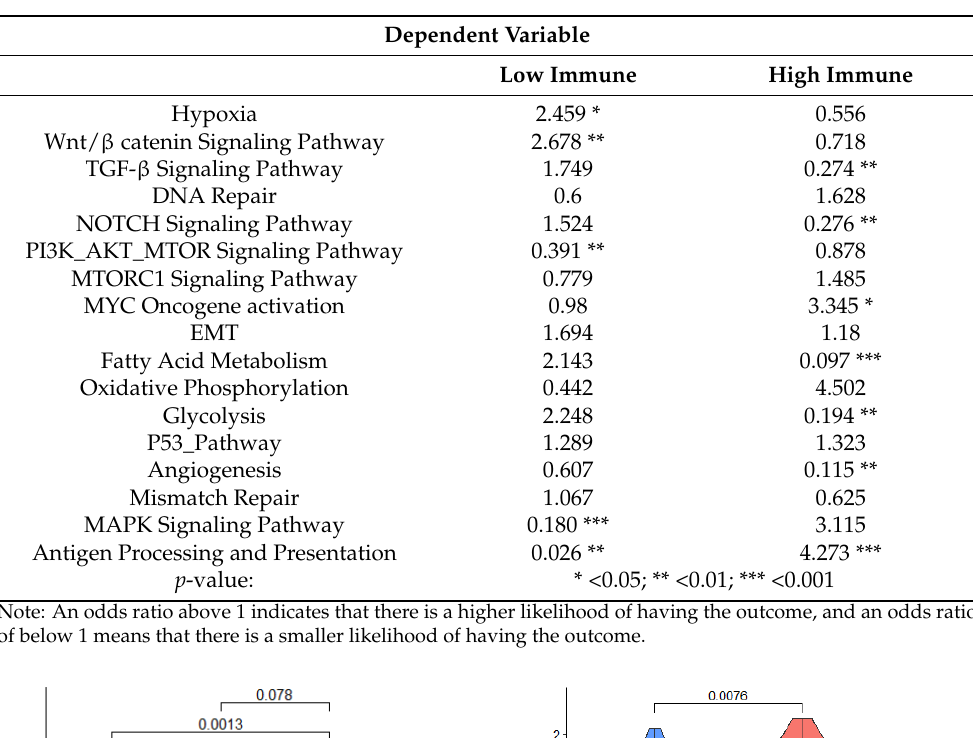
Table 1. Result of multinomial logistic regression in melanoma TCGA sample.